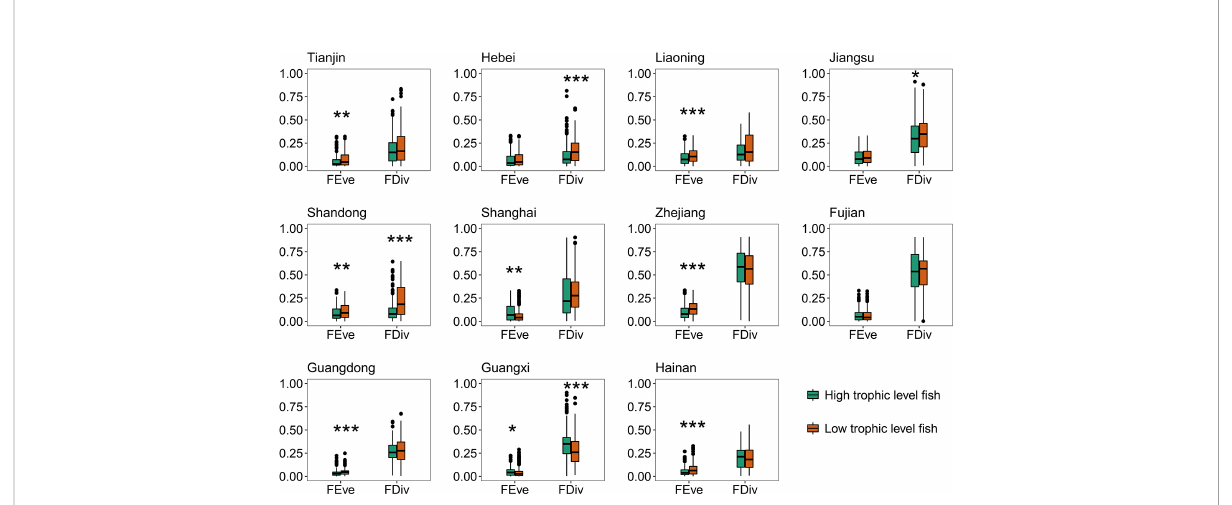
FIGURE 3 Comparison of relative contributions of fi shes with different trophic levels to functional diversity for 11 provinces. The results of Wilcoxon rank- sum tests are shown upon each plotted item (* p < 0.05; ** p < 0.01; *** p < 0.001; Supporting Information Table S5 shows the complete Wilcoxon rank-sum tests. FEve, functional evenness; FDiv, functional divergence).